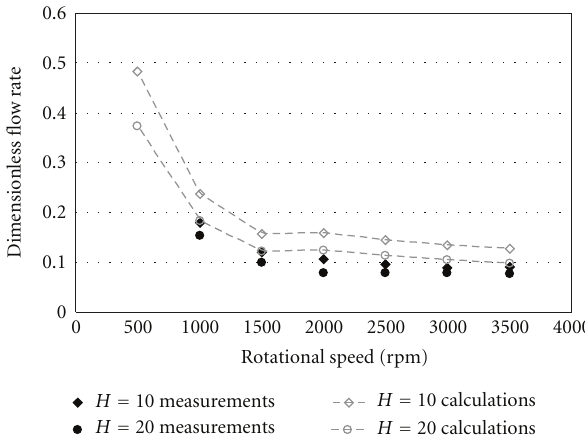
Figure 11: Comparison between experimental and numerical